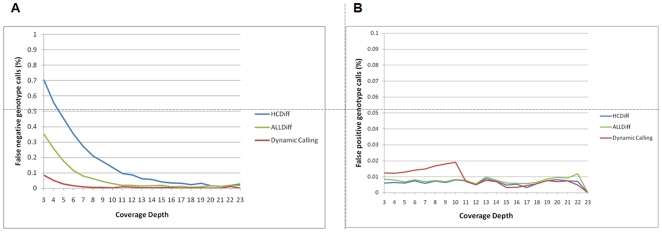
Estimated error rates.Sensitivity of genotype calling based on HCDiff SNPs, AllDiff SNPs, and the proposed coverage-dependent genotype calling approach. A) False negative rates are based on concordance with a subset of 44,513 SNPs that overlapped with genotypes obtained with Illumina 1 M Duo BeadChips. The coverage-dependent variant calling approach that calibrates cut-off rates according to array-based genotypes is the most sensitive method, detecting >96% of SNPs at 5x coverage and >99% of all SNPs at ≥8x coverage. B) False positive rates. HCDiff is the most conservative algorithm, resulting in a smaller false positive rate, while the more relaxed dynamic genotype calling algorithm results in twice as high error rates at lower coverage.